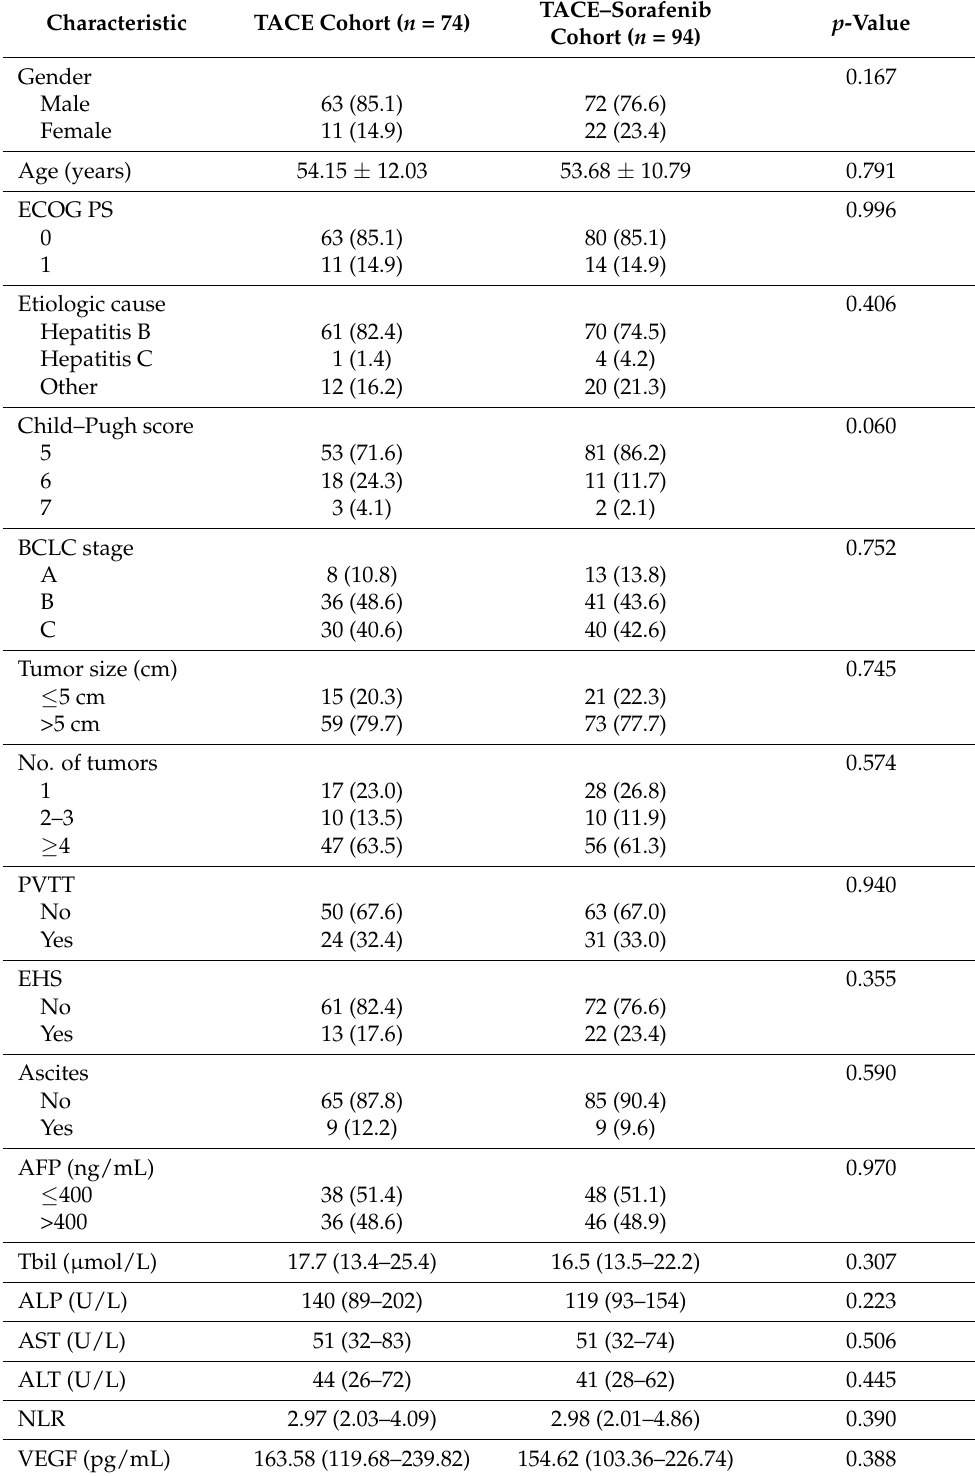
Table 1. Baseline demographics and clinical characteristics of patients in two